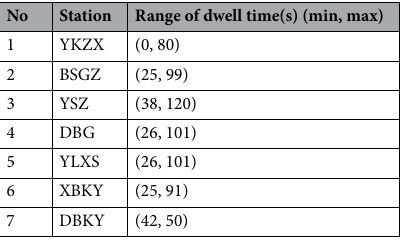
Table 3. The range for dwell time.